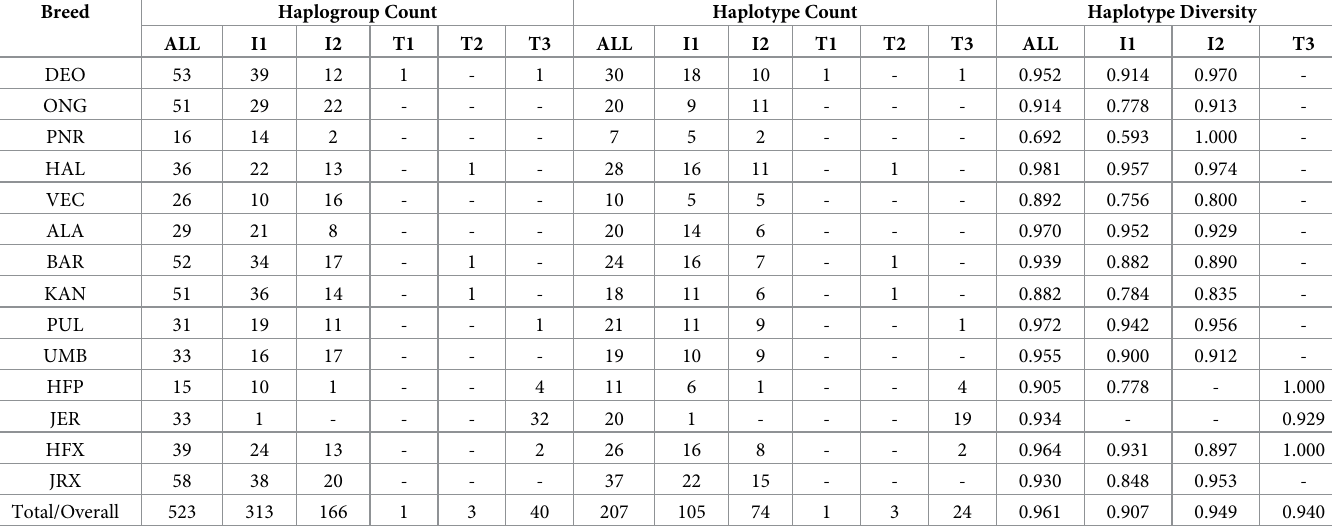
respectively (Table 5). The overall haplotype diversity within I1 haplogroup and I2 haplogroup was 0.907 and 0.949 respectively. The haplotype diversity within I2 haplogroup was higher than that of I1 in all the South Indian zebu cattle breeds except Alambadi. Among the observed haplotypes, 27 were found to be shared across 2 or more breeds, of which 18 belonged to I1 haplogroup, 8 belonged to I2 haplogroup and one belonged to T3 haplogroup (S5 Table). A total of 139 singleton haplotypes were observed, of which 67, 50, 18, 3 and one belonging to I1, I2, T3, T2 and T1 haplogroups respectively. The higher proportion of singleton haplotypes within I2 haplogroup of South Indian cattle was consistent with relatively higher haplotype and nucleotide diversity observed within this lineage. Table 4. Haplogroup classification and diversity of mtDNA control region haplotypes in zebu, taurine and crossbred cattle of South India. Breed Haplogroup Count